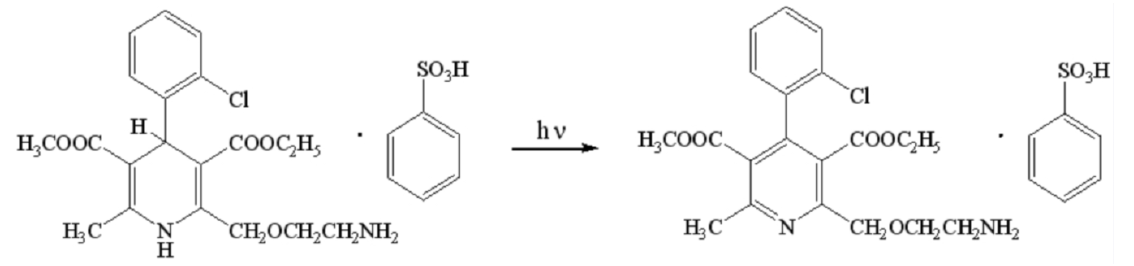
Figure 1. Amlodipine besylate degradation to the pyridine derivative under the influence of